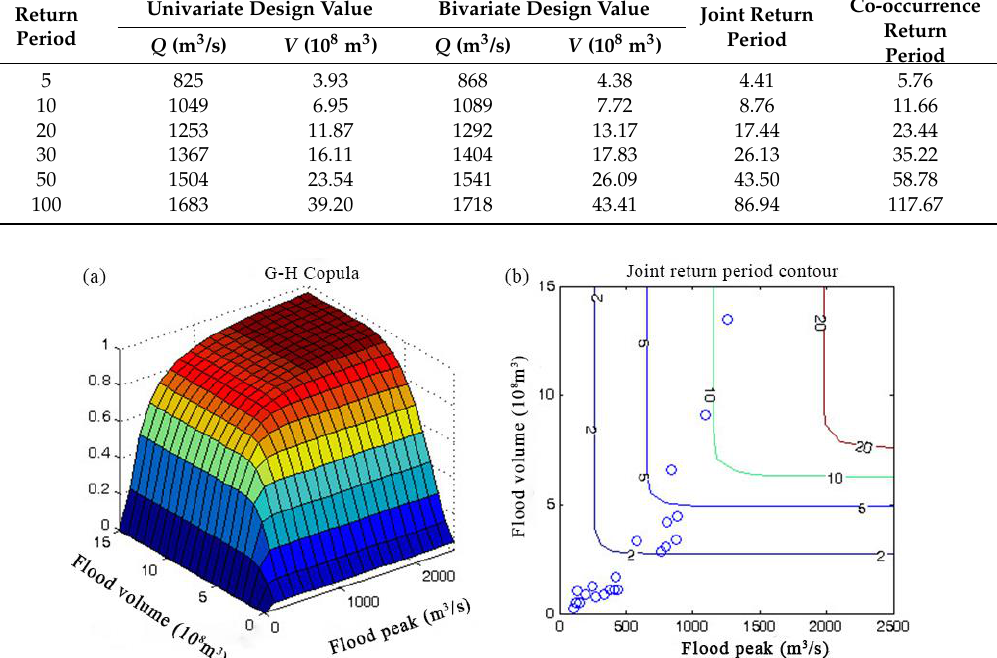
Figure 5. ( a ) Peak-volume joint distribution; ( b ) The contour of peak-volume joint return period.